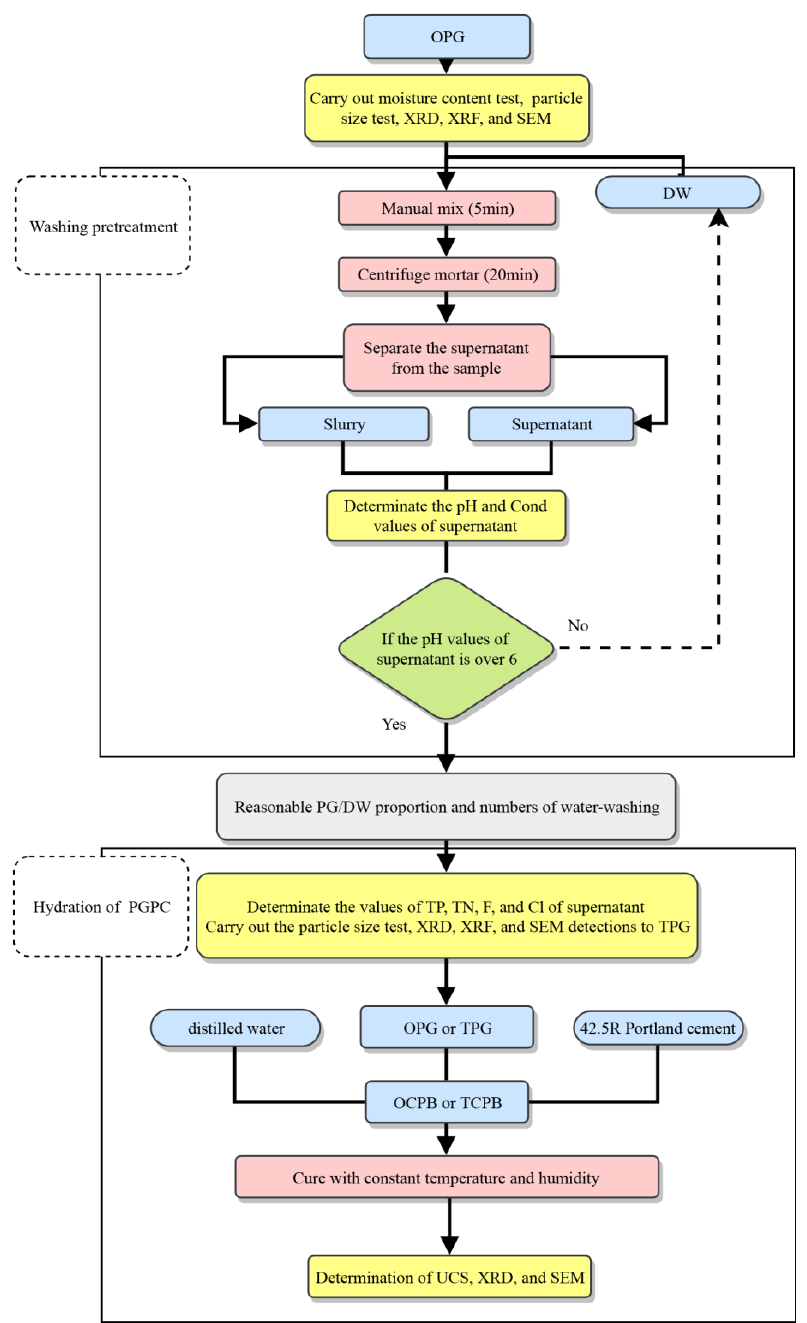
Figure 1. Flow chart of the experiments.